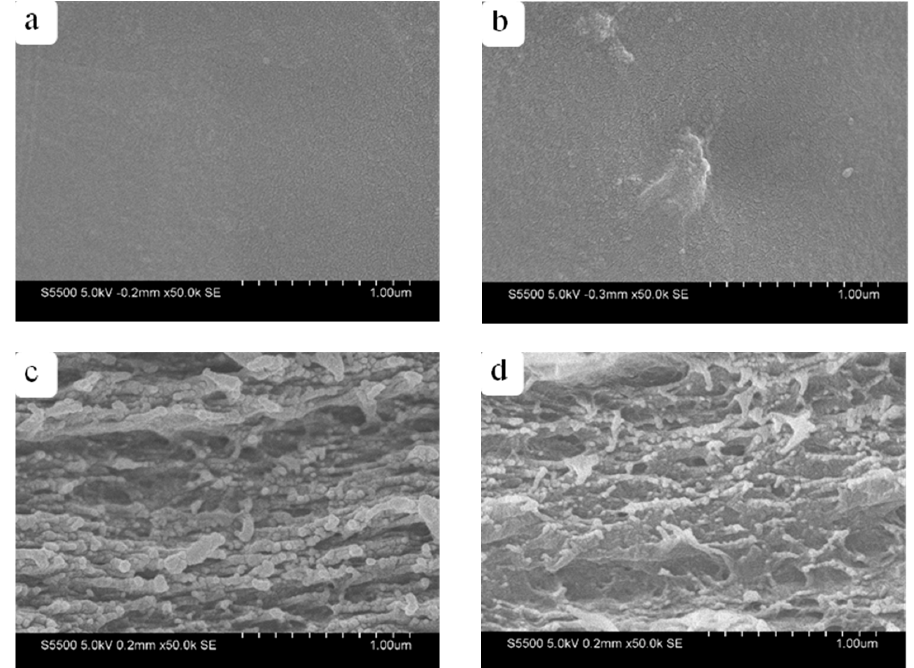
Figure 5. Morphologies of RWSCs prepared by AM and Composite-A films; ( a , b ) surface; ( c , d ) cross-section.